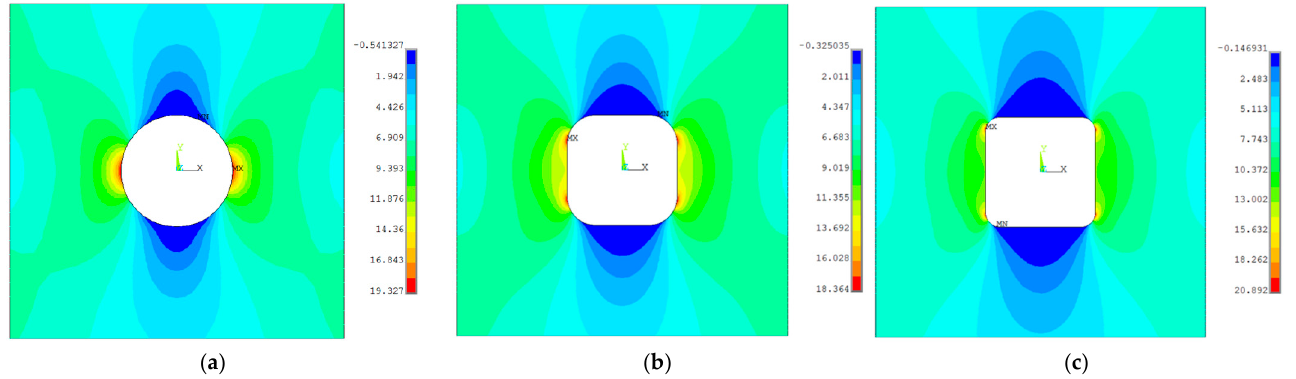
Figure 22. Distribution of σ y stress for three analyzed samples without reinforcements: ( a ) circular hole—sample 2; ( b ) rectangular hole with fillet radius R4—sample 3; ( c ) rectangular hole with fillet radius R2—sample 4.